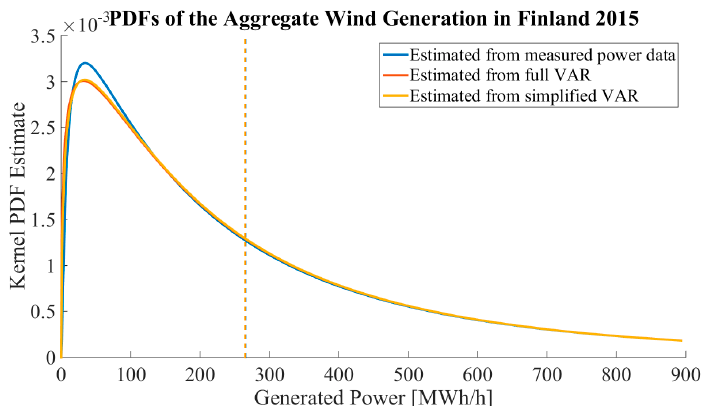
Figure 8. The PDFs estimated from the measured aggregated wind power generations in Finland in 2015 and from the aggregated simulated data from the two models. The dotted lines illustrate the average power generation during 2015 with the corresponding colors (the dotted lines are overlapping). The presented simulation results are averages of the 100 MC runs.